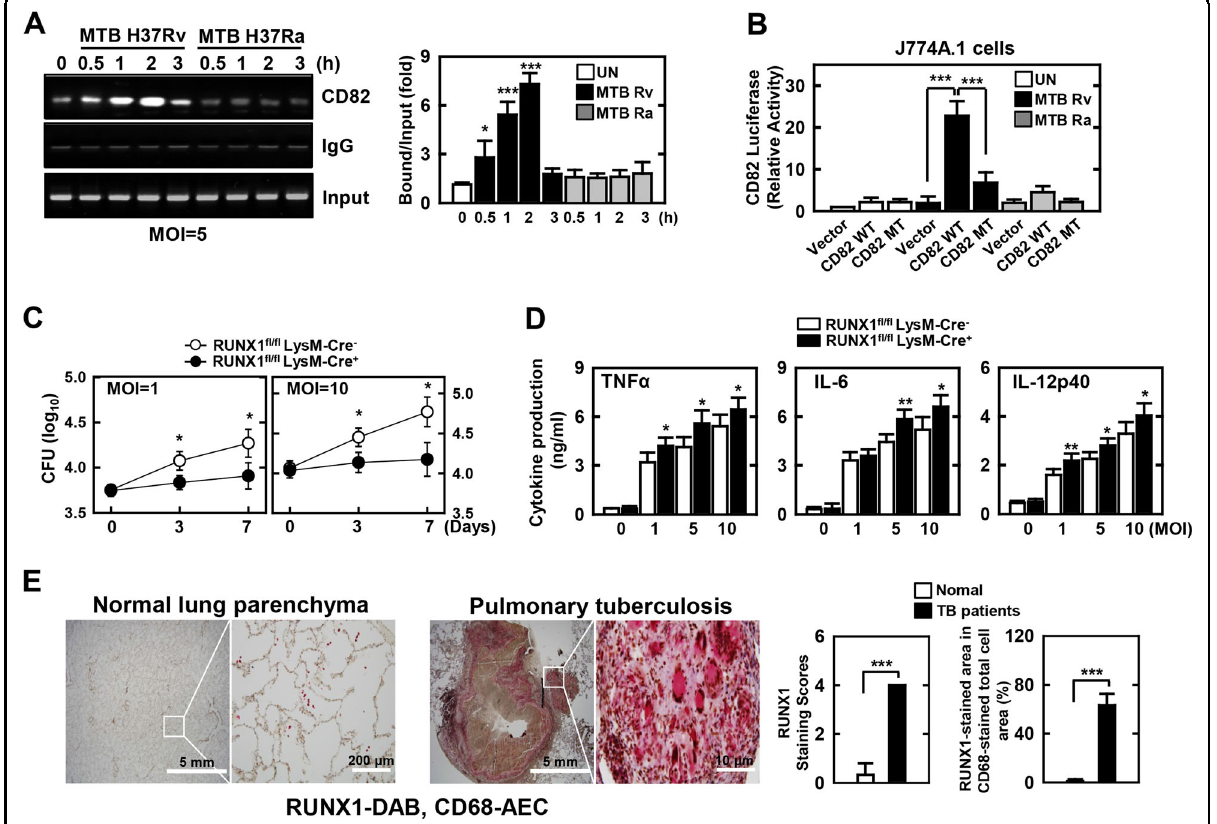
Fig. 6 CD82 associates with RUNX1. a ChIP analyses of RUNX1. (Left) BMDMs were infected with MTB Rv for the indicated times, and subjected to semi-PCR analysis using primers speci fi c for CD82. The data are representative of four independent experiments with similar results. (Right) The densitometry results of all four independent RUNX1-CD82 ChIP assays. b J774A.1 cells were transfected with CD82-luciferase reporter constructs (CD82 WT or MT carrying point mutations in the critical RUNX1-binding site) and infected with MTB Rv (MOI = 5) for 6 h. The promoter activities were determined by luciferase assays and normalized to Renilla luciferase enzyme activities. c , d BMDMs from RUNX1 fl / fl LysM-Cre + and RUNX1 fl / fl LysM- Cre- mice were infected with MTB Rv for the indicated times, followed by c intracellular survival of MTB assessment by CFU assay or d culture supernatant harvesting at 18 h and analysis by cytokine ELISA for TNF α , IL-6, and IL-12p40. e Immunohistochemical analysis to examine RUNX1-DAB and CD68-AEC expression levels in healthy controls and patients from pulmonary TB. Representative images from 5 independent healthy controls and patients are shown. Insets, enlargement of outlined areas. Data shown are the means ± SD of fi ve experiments ( b – d ). Signi fi cant differences (* P < 0.05; ** P < 0.01; *** P < 0.001) compared with MTB Ra or RUNX1 fl / fl LysM-Cre- (Student ’ s t- test with Bonferroni adjustment). CFU colony-forming